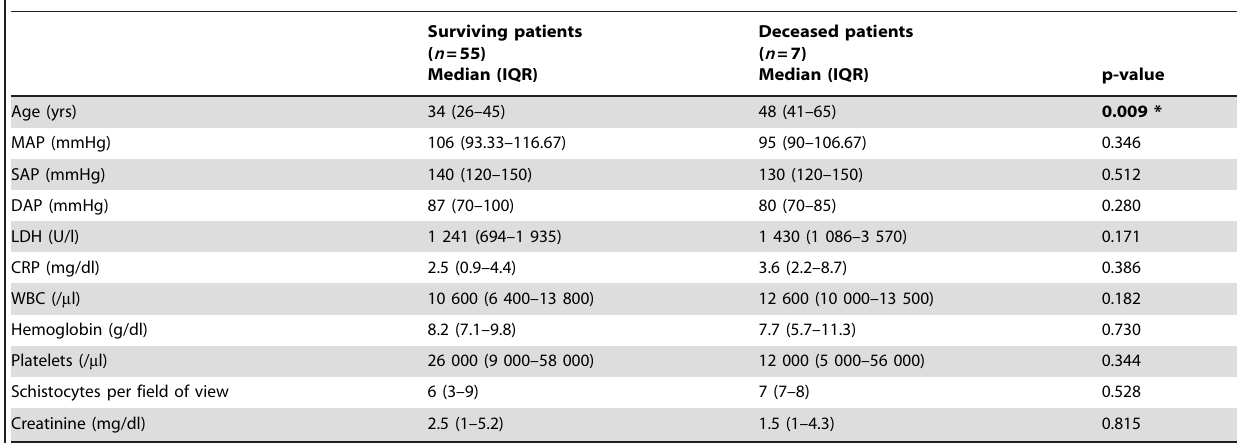
Table 6. Risk factors for TMA-associated